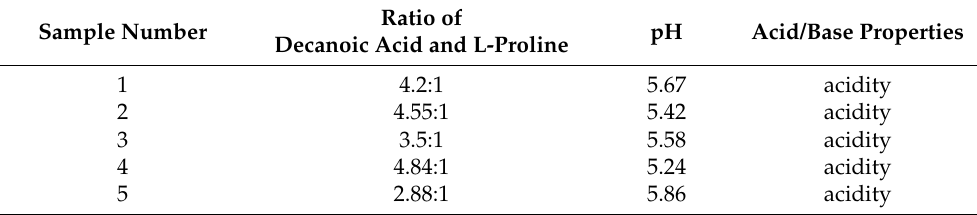
Table 1. pH of NADESs with different molar